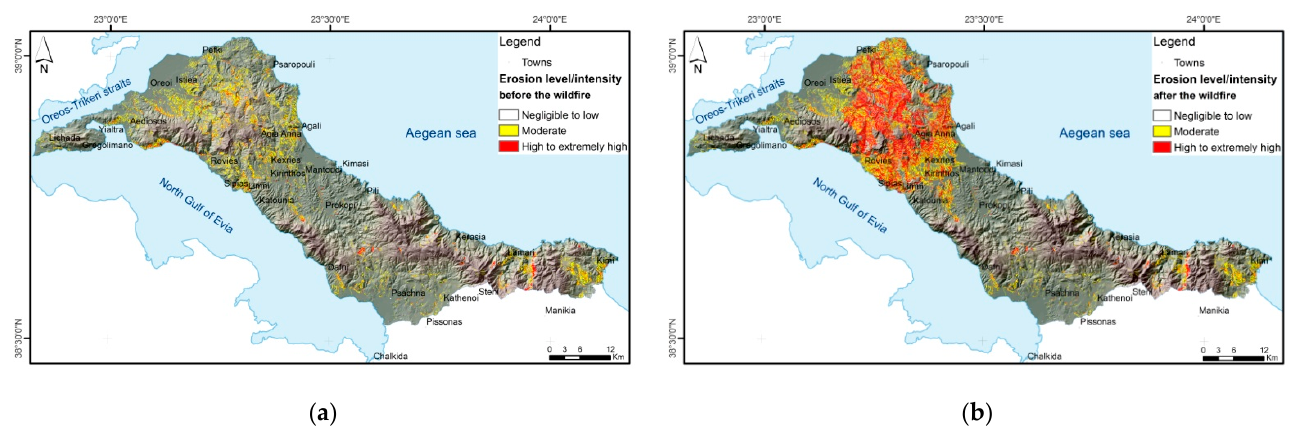
Figure 6. Erosion level maps of the study area under the ( a ) natural/pre-fire condition and ( b ) post- fire condition.